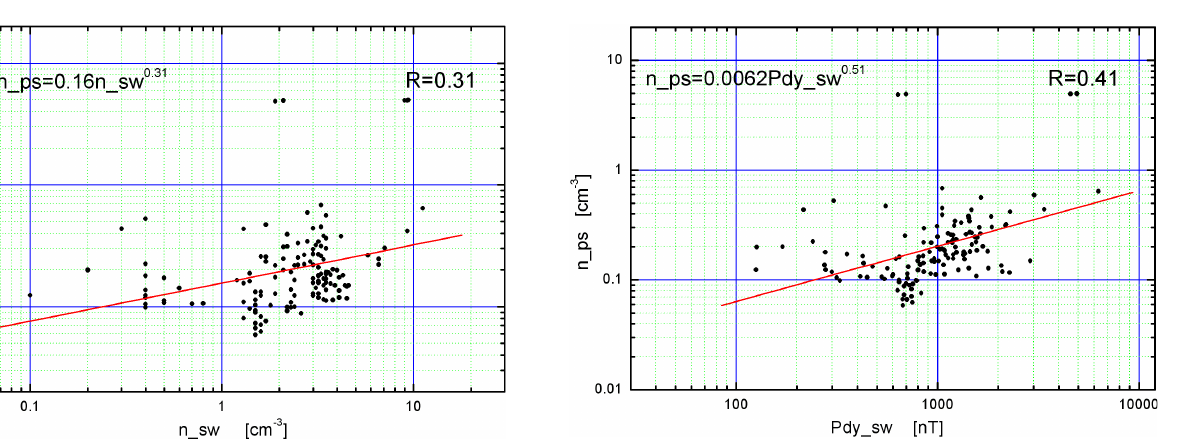
Fig. 2. The relationship between the density of the solar wind and that in the plasma sheet.